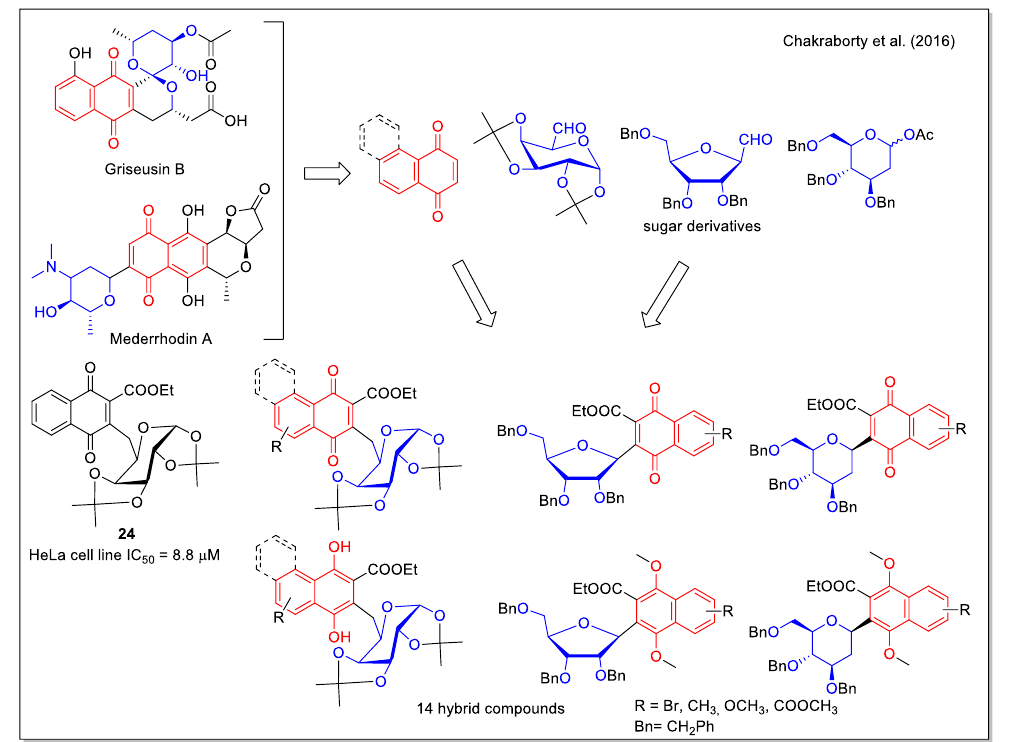
Figure 8. 1,4-Naphthoquinone-carbohydrate hybrids as reported by Chakraborty et al. [38].